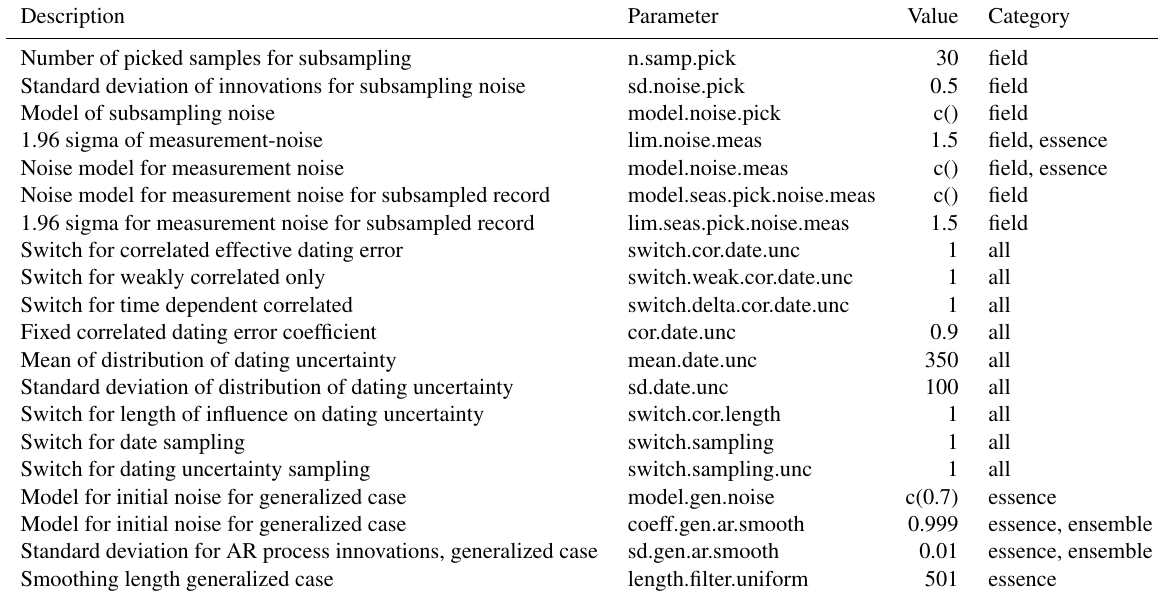
Table A3. Continuation of list of parameters used. Description Number of picked samples for subsampling